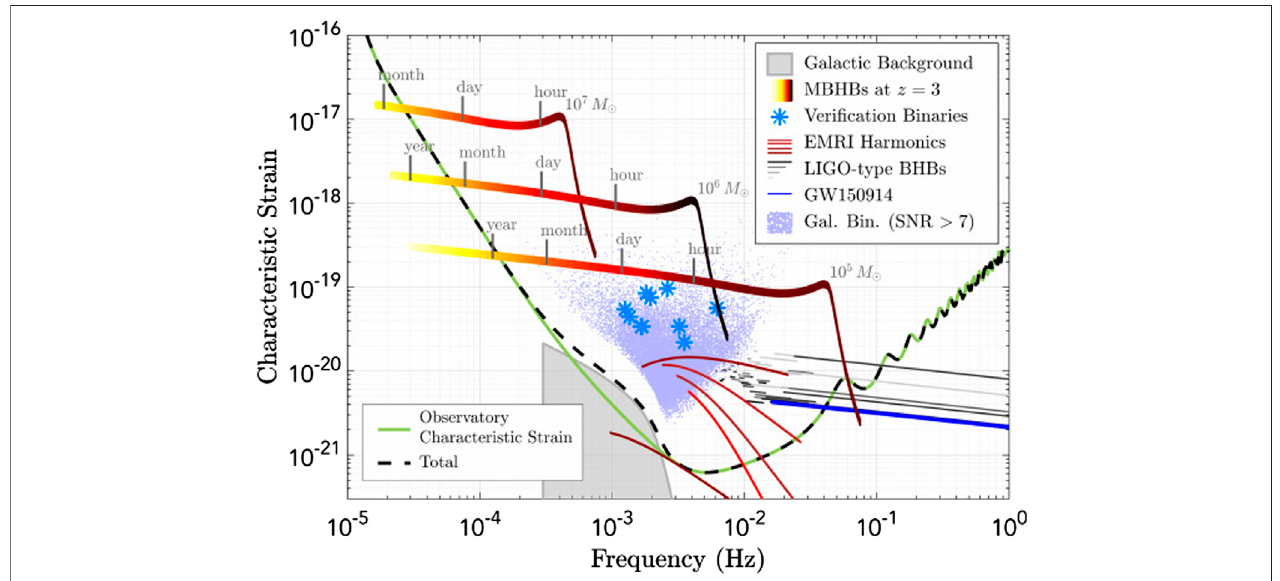
FIGURE 1| Thedimensionless “ characteristicstrain ” ofGWsourcesintheLISAfrequencyband.Thenominaldetectorsensitivityisshownbythegreenline.Displayed are tracksofthree equalMBHBs at z (cid:2) 3 withtotalmasses of10 5 , 10 6 , 10 7 M ⊙ ,the fi rst fi veharmonics ofanEMRI at z (cid:2) 1 . 2 (redsolid lines), asample ofstellar-massBHBs (black solid lines), and several thousands of resolvable galactic binaries (blue dots). The subset of known “ veri fi cation binaries ” is shown with blue asterisks. The “ confusion noise ” arising from the millions of galactic binaries that cannot be resolved individually is shown by the gray shaded area (Amaro-Seoane et al., 2017).